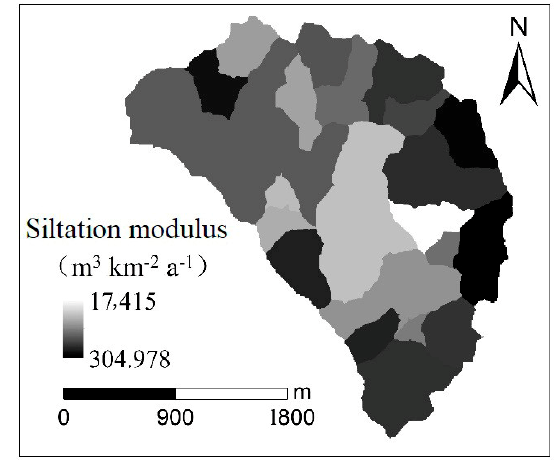
Figure 8. Siltation modulus diagram of the Wangmaogou watershed.